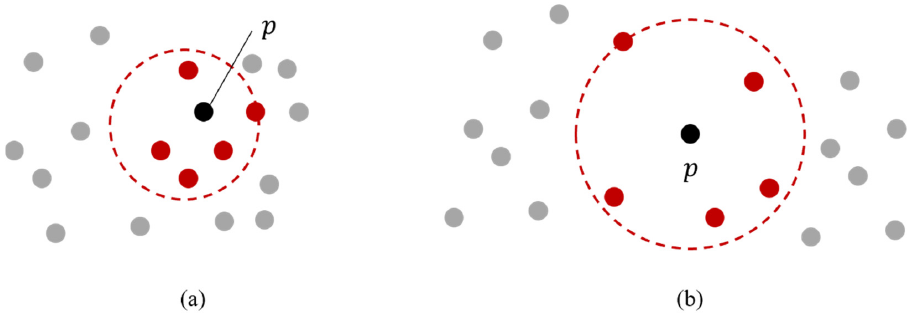
Figure 2. Example of ( a ) p is an inlier ( b ) p is an outlier where k is set to 5.